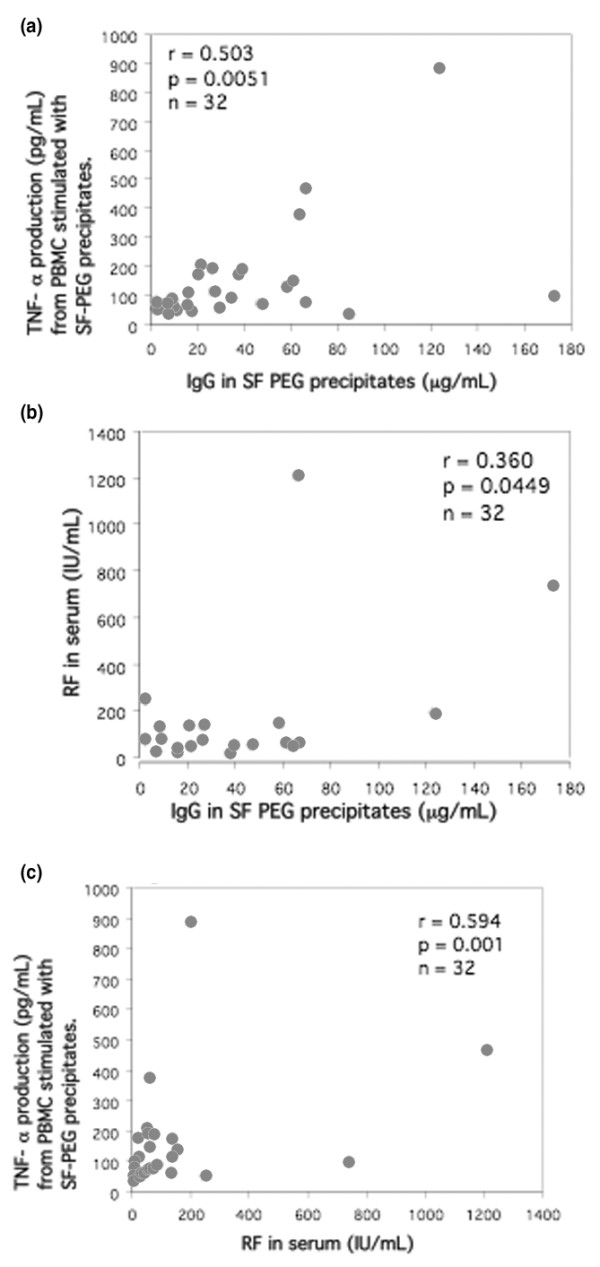
Correlation between SF precipitate induced TNF-α production, IgG levels in SF precipitates, and RF (n = 32). Healthy PBMCs were stimulated with PEG precipitates from SF from 32 patients with RA. The stimulated cells were cultured for 20 hours at 37°C with 5% carbon dioxide. IgG levels in the SF precipitates correlated with (a) TNF-α production after SF PEG stimulation and (b) with RF measured in serum. (c) There was also a correlation between RF and TNF-α induced by SF PEG precipitates. Statistical analyses were performed with nonparametric tests to diminish the effect of outliers. PBMC, peripheral blood mononuclear cell; PEG, polyethylene glycol; RA, rheumatoid arthritis; RF, rheumatoid factor; SF, synovial fluid; TNF, tumour necrosis factor.